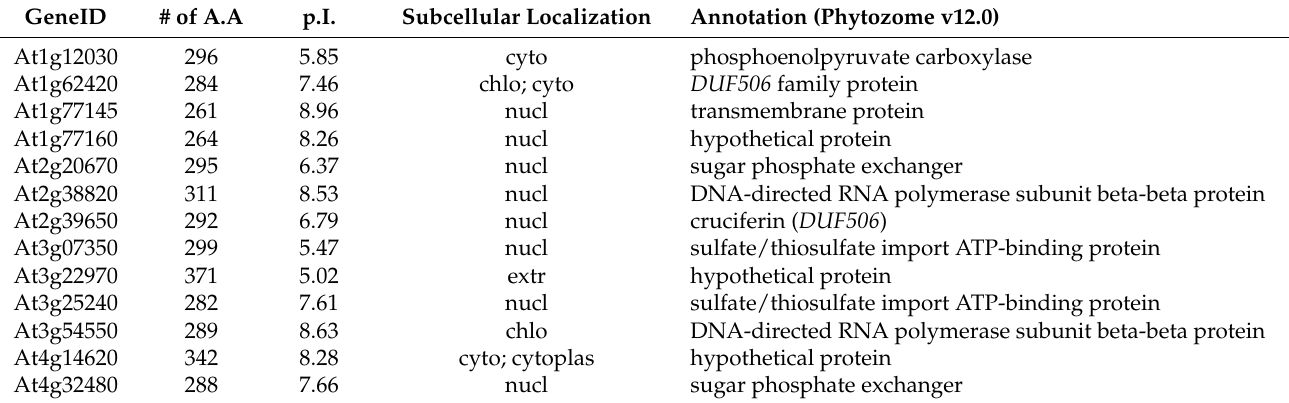
Figure 2. Phylogenetic representation and distribution of the conserved motifs in DUF506 among angiosperms. ( a ) The phylogenetic tree was constructed based on full-length DUF506 amino acid sequence alignments from 17 species. DUF506 from monocots are represented by blue hollow dots, while those from dicots are represented by blue solid dots. DUF506 from Amborella trichopoda (basal angiosperm) are represented by red solid dots. The distribution of DUF506 conserved motifs ( b ) and the corresponding sequence logos ( c ) in plants are shown. Note that, the conserved β -sheet structures are mainly localized in Motif 2. Table 1. Physicochemical properties of DUF506 family members in Arabidopsis.